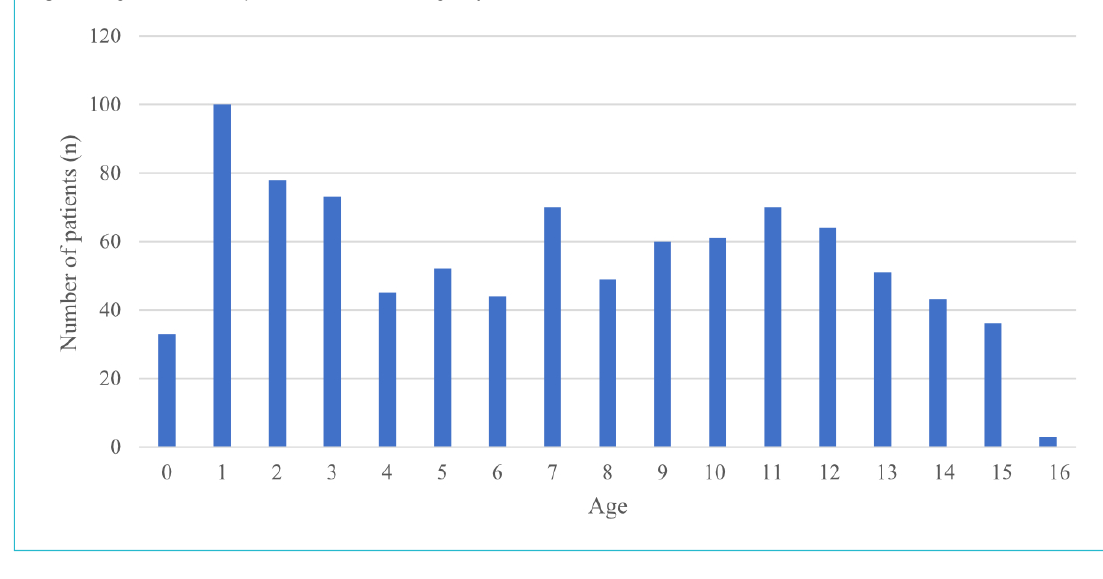
Table 1: Frequency and type of injury according to